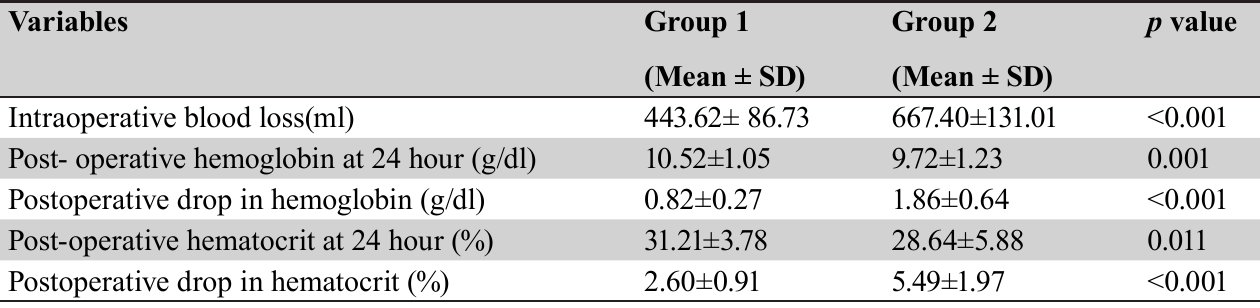
Table 3. Blood loss and post-operative blood parameters (N=100). Variables